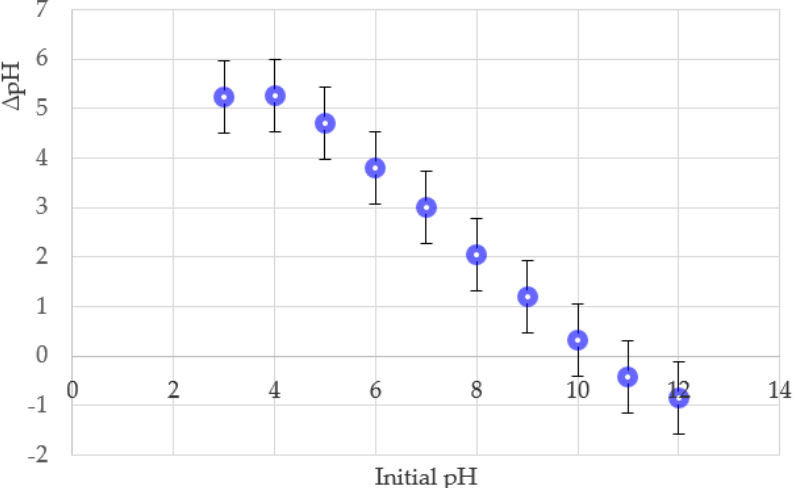
Figure 6. The plot of ∆pH vs. initial pH for the determination of 4AZW’s point of zero charge.